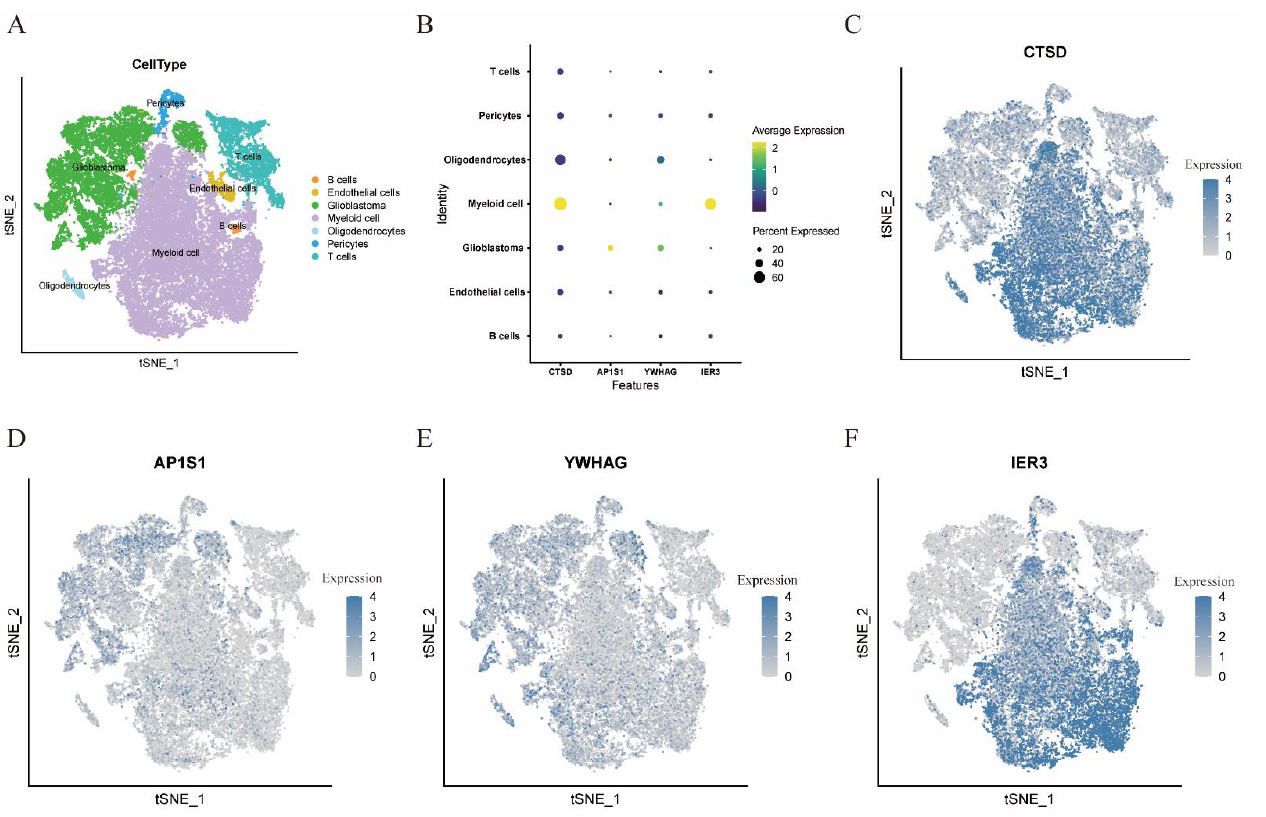
Figure 6. Single-cell sequencing analysis to explore the cell localization of 4 modeling genes. ( A ) The location of different cell types in GBM. ( B – F ) CTSD expression was highest in myeloid cells, high expression of AP1S1 was shown in glioblastoma cells, YWHAG was mainly expressed in glioblastoma cells, oligodendrocytes, and myeloid cells, and IER3 was predominantly expressed in myeloid cells.